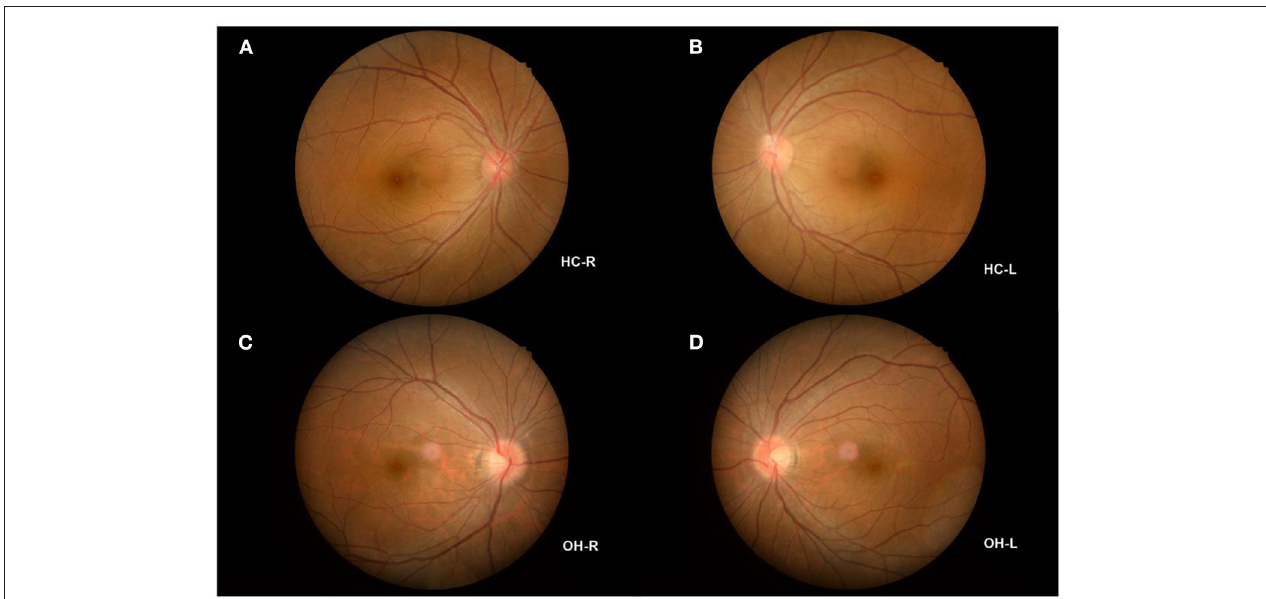
FIGURE 1 | Example of OH and HC observed using a FC. (A) The fundus of HC-R; (B) The fundus of HC-L; (C) The fundus of OH-R; (D) The fundus of OH-L. OH, ocular hypertension; HC, healthy control; R, right; L, left; FC, fundus camera.